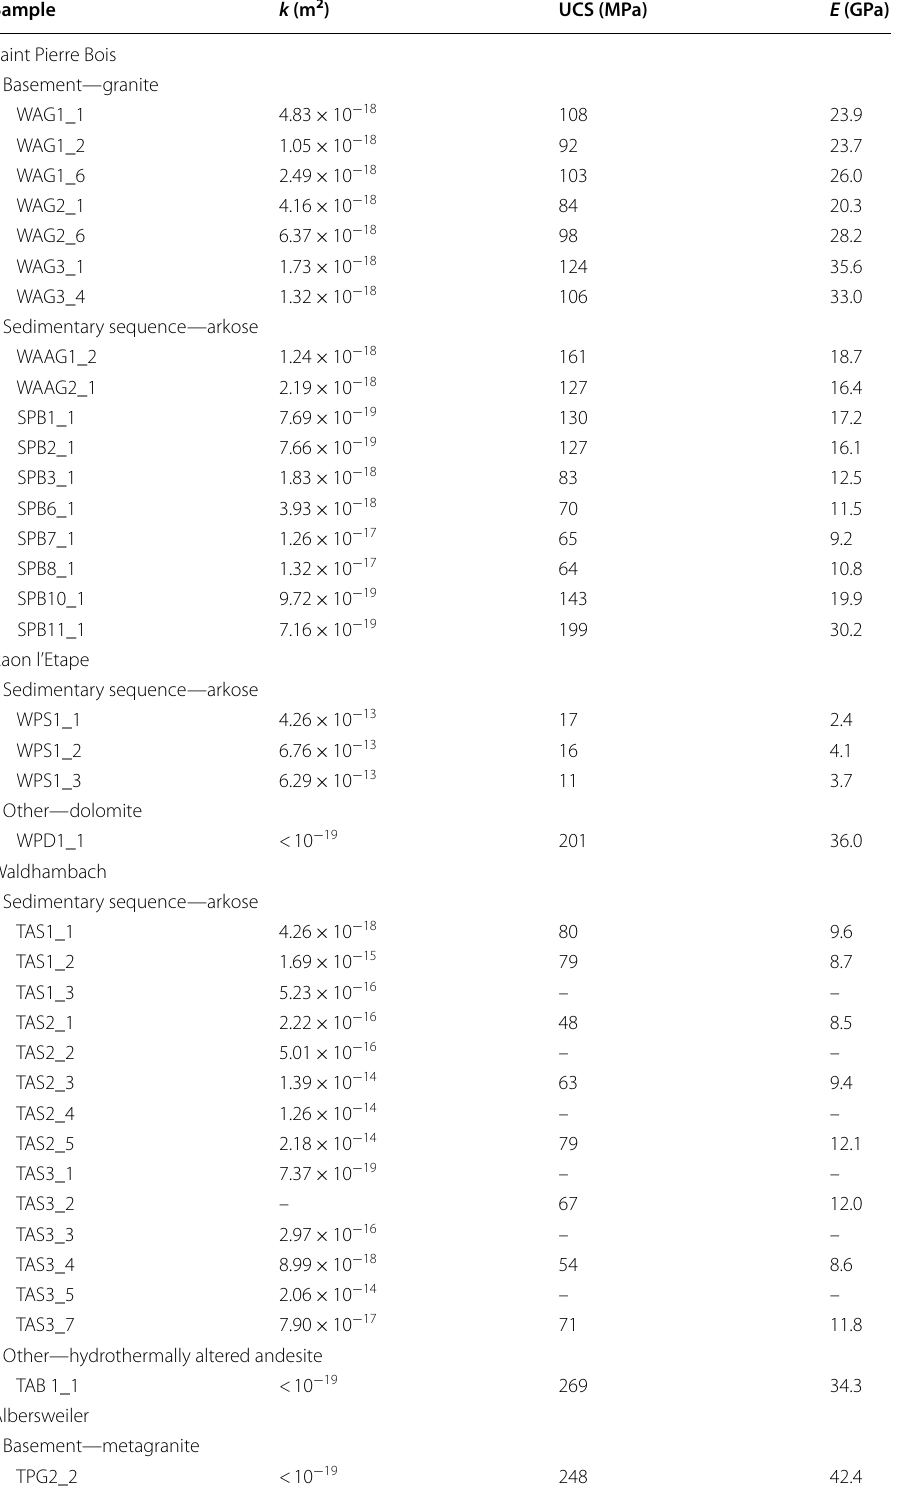
Table 3 Permeability and mechanical properties of selected sample